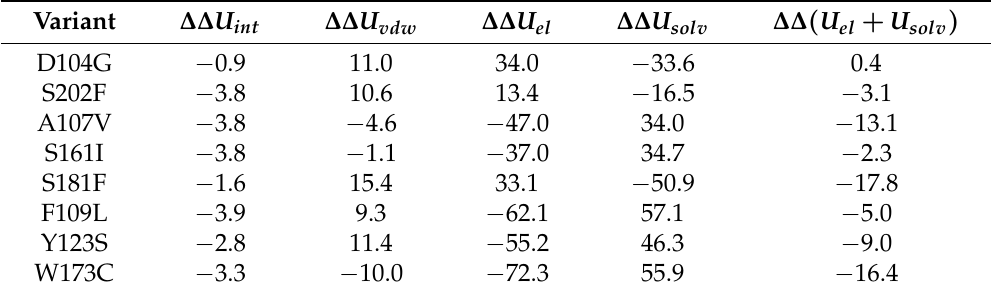
Table 4. Difference in change of energy components (kcal/mol) when imposing average values of CV to 4 and using as reference the imposed average of 14. Equation (12) is used to replace H in Equation (10) for the free energy decomposition. U int is the sum of stretching, bending and torsional components in Equation (13); U vdw is the sum of Lennard-Jones interactions for all atomic pairs in the protein; U el is the sum of Coulomb interactions for all atomic pairs in the protein; U solv = U solv , np + U solv , pol (Equation (12)). See Methods for